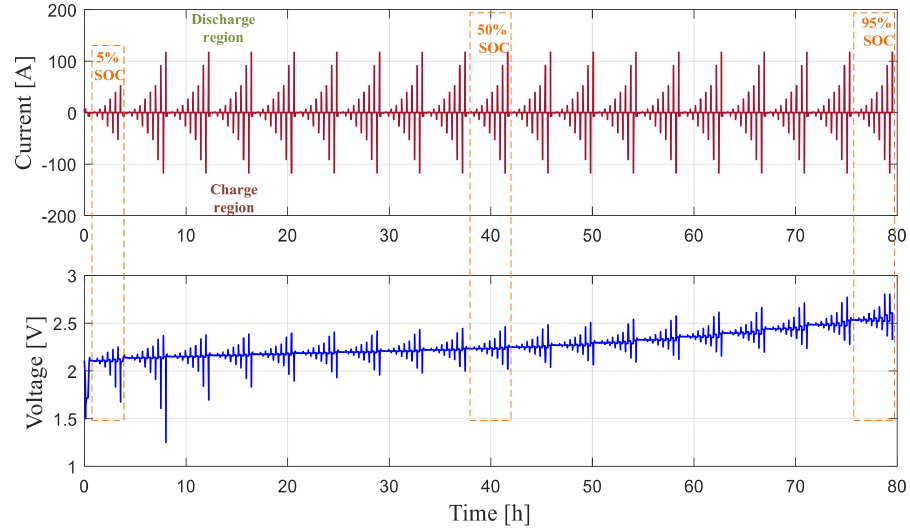
Figure 6. Current pulse and voltage profiles.